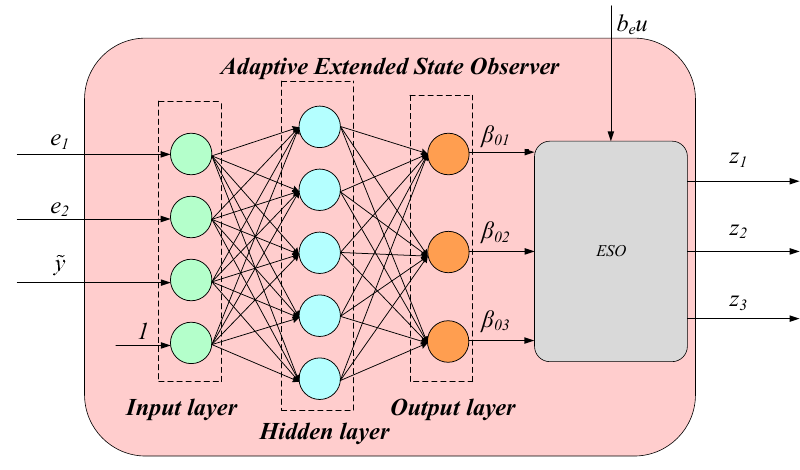
Figure 5. Structure of AESO.